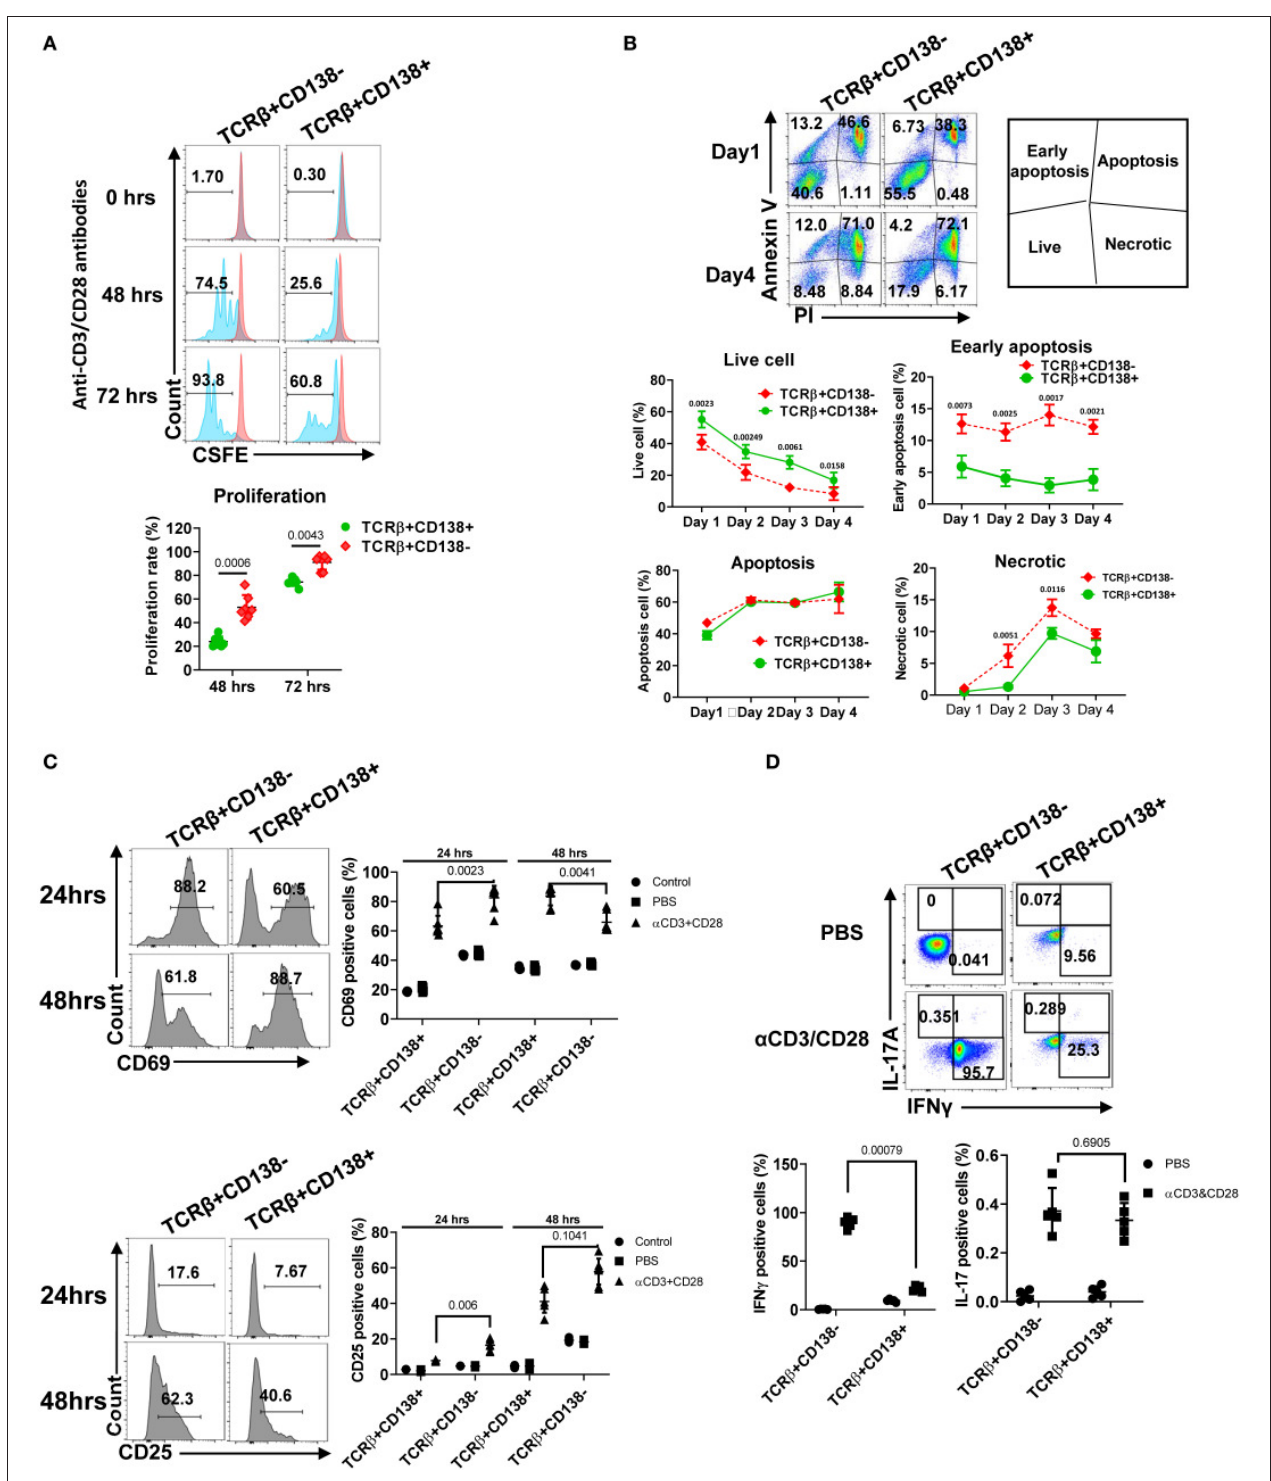
FIGURE 3 | TCR β + CD138 + cells proliferate less and resist early apoptosis after activation. (A) Splenic TCR β + CD138 + and TCR β + CD138- were sorted with magnetic beads and pre-stained with CSFE prior to stimulation with anti-CD3/CD28 antibodies for 3 days. The proliferation was assessed by flow